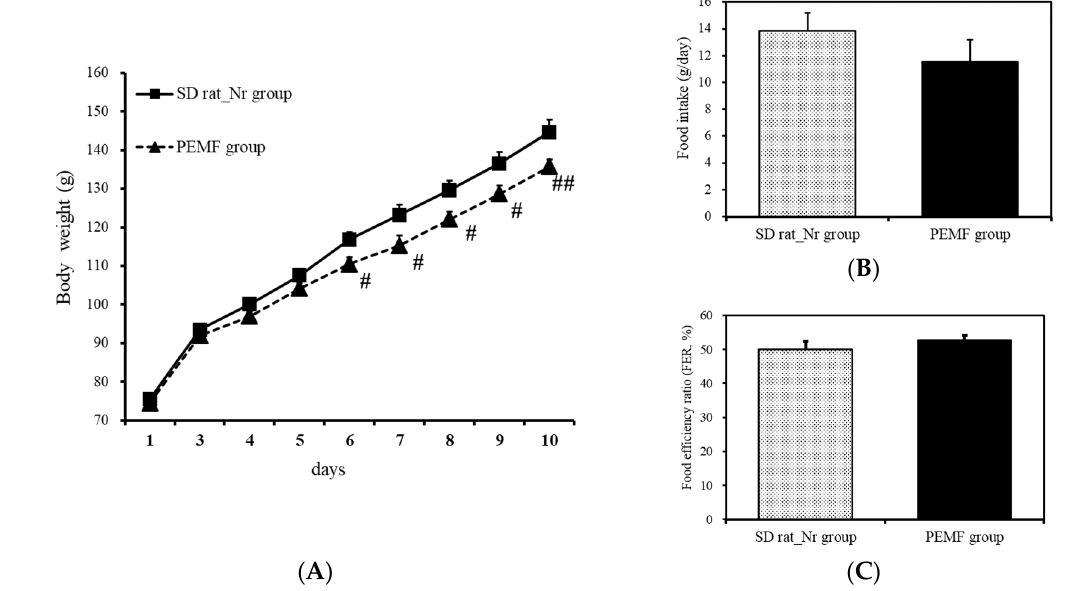
Figure 6. Body weight and food intakes. ( A ) Body weight change, ( B ) food intake, and ( C ) food efficiency ratio. Results are expressed as means ± SEM (n = 8). # p < 0.05 and ## p < 0.01 compared with the normal group.